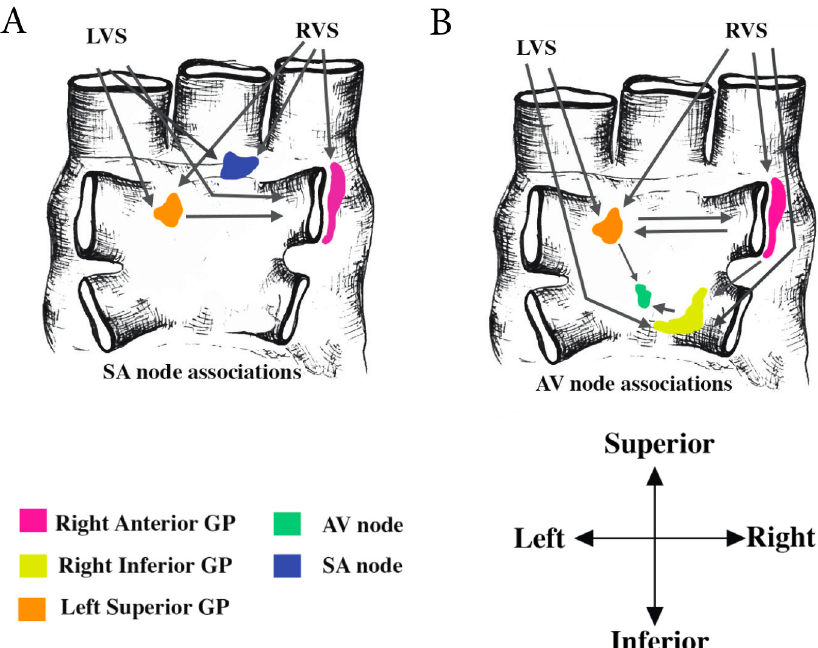
Figure 3. Posterior view of the atria showing the interactions between neural pathways. ( A ): Arrows indicate the direction of impulse and the connections of the left vagosympathetic trunk (LVS) and right vagosympathetic trunk (RVS) with the anterior right (AR) and superior left (SL) GPs. These pathways have been shown to modulate the effects of the sinoatrial node (SA) node and attenuate sinus rate slowing. ( B ): Arrows indicate the direction of impulse and connections involving the LVS and RVS trunks, with the SL, AR and inferior right (IR) GP’s. These pathways have been shown to influence atrioventricular node (AV) node function and ventricular rate response. The inferior left GP (ILGP) acts as a pivotal element in the connection pathway to the AV node.